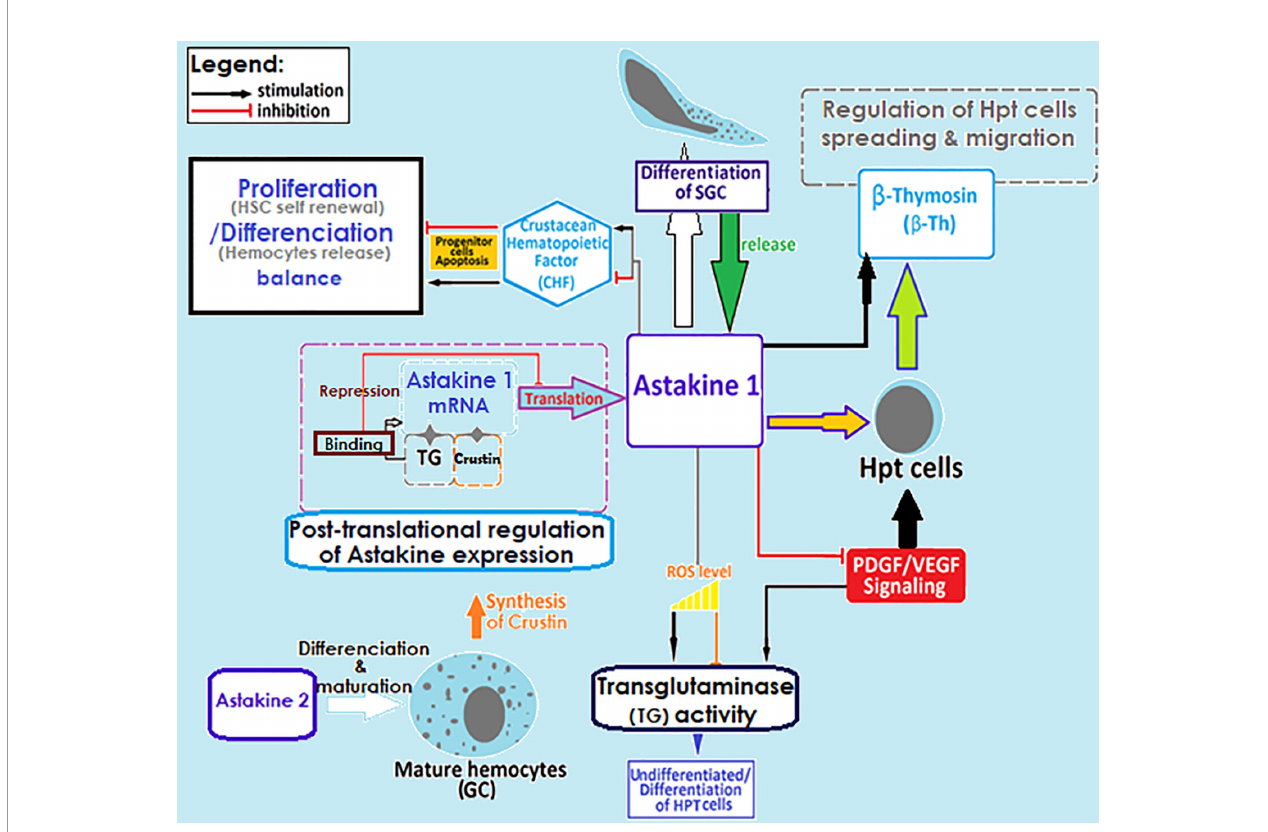
FIGURE 3 | Regulation of cray fi sh hematopoietic mechanisms. Molecular factors involved in the regulation of hemocyte production. SGC, semi granular cells; GC, granular cells; TG, transglutaminase; ROS, reactive oxygen species; HPT cell, hematopoietic cells; HSC, hematopoietic stem cells (29, 45, 47, 75, 83 –